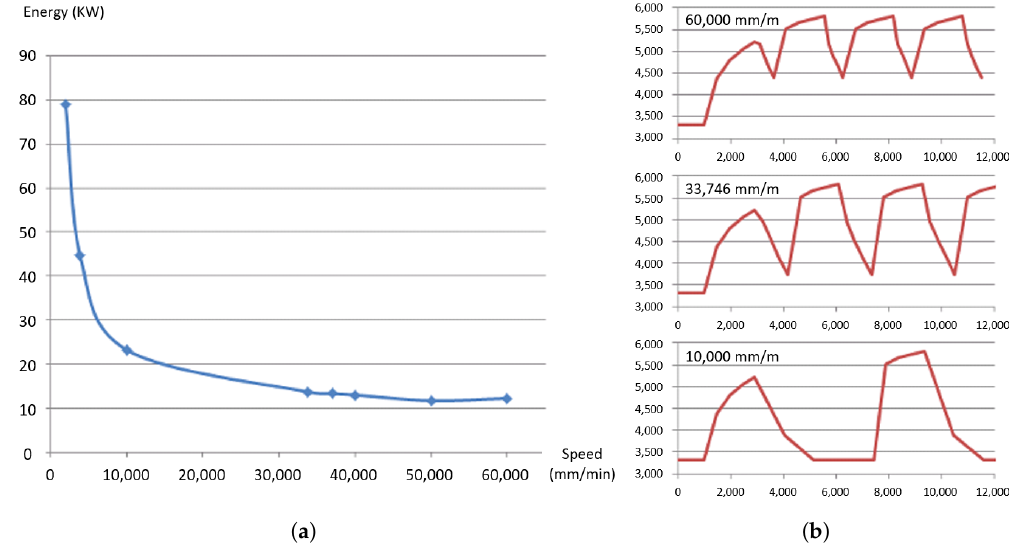
Figure 18. ( a ) Relationship between welding speed and energy use; ( b ) energy profiles for varying speeds. Comparison of the energy profile in different operating